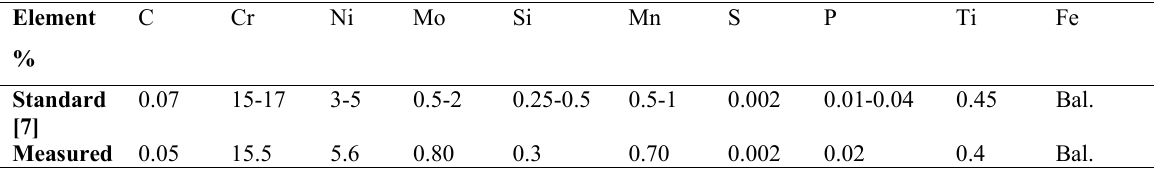
The chemical composition of the used